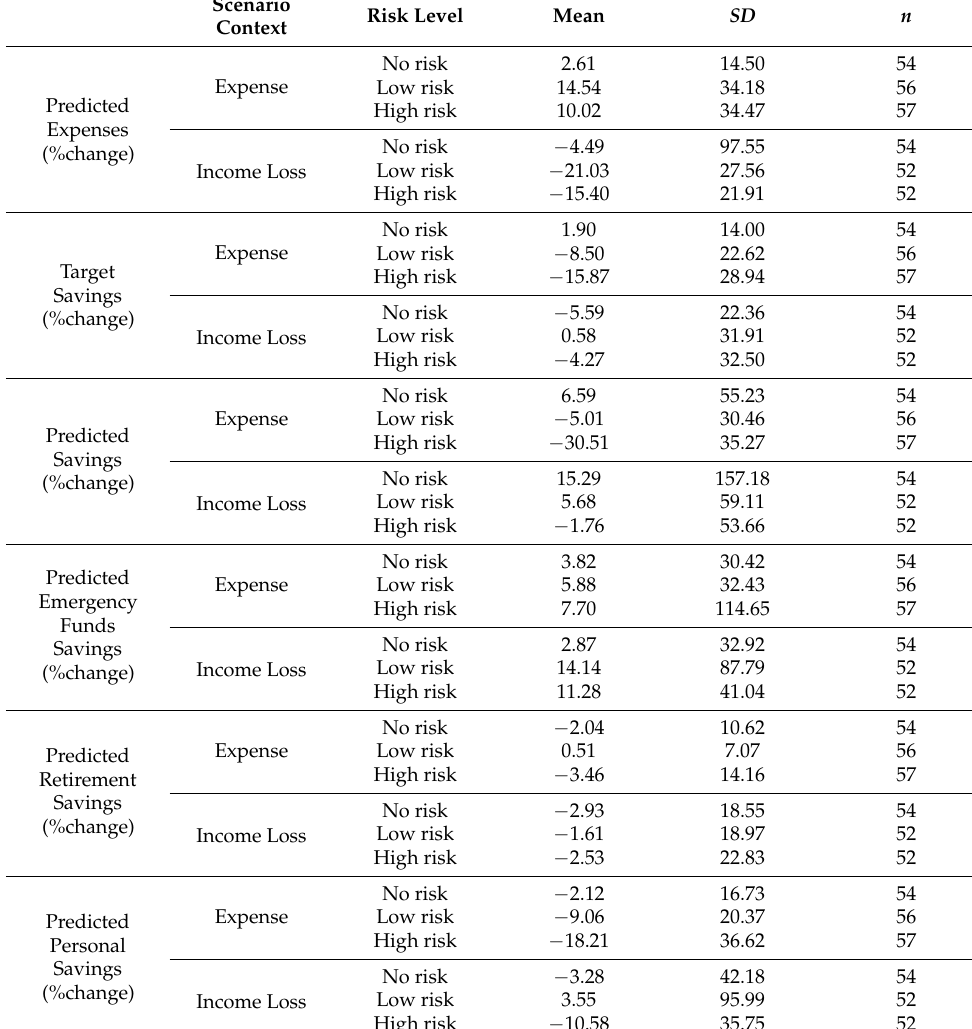
Table A2. Means and SD ’s of the dependent variables across scenario context and risk